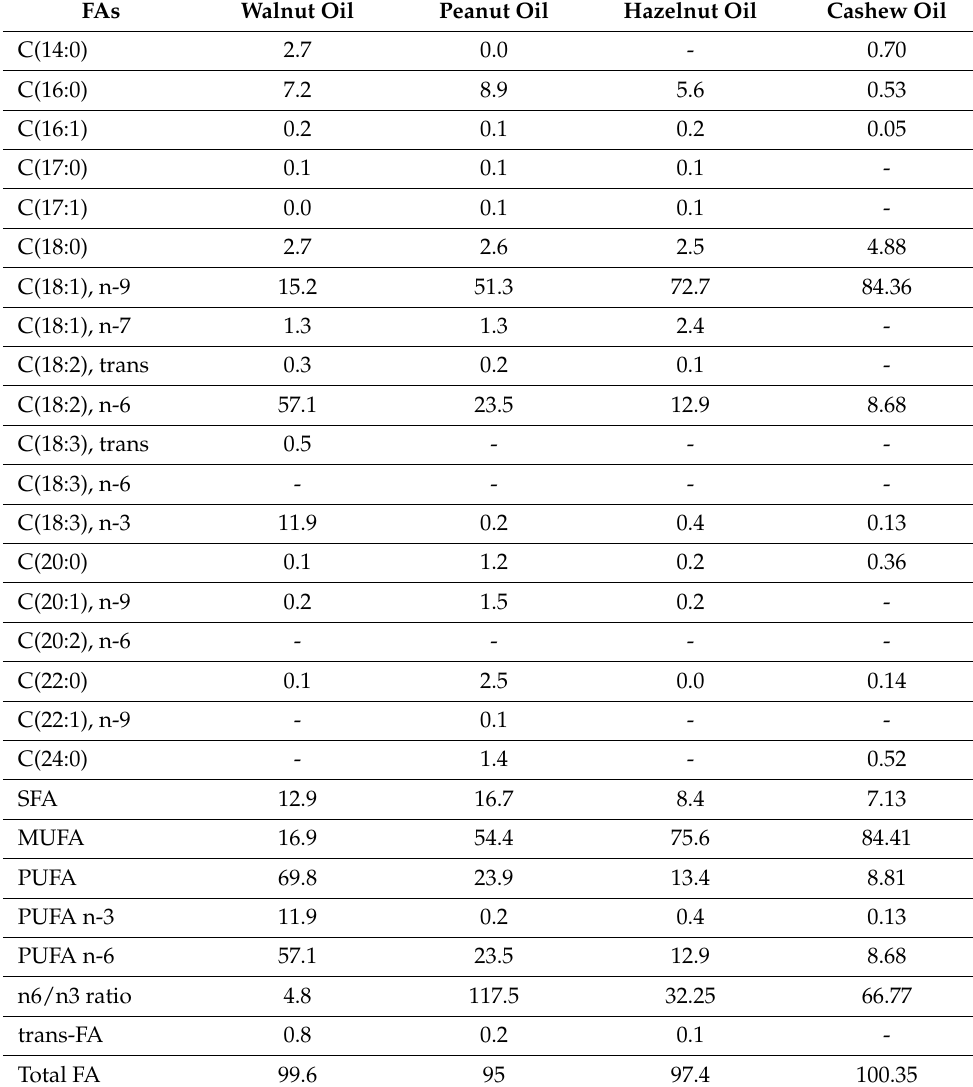
Table 1. Fatty acids composition of different oils used in this study (g/100 g